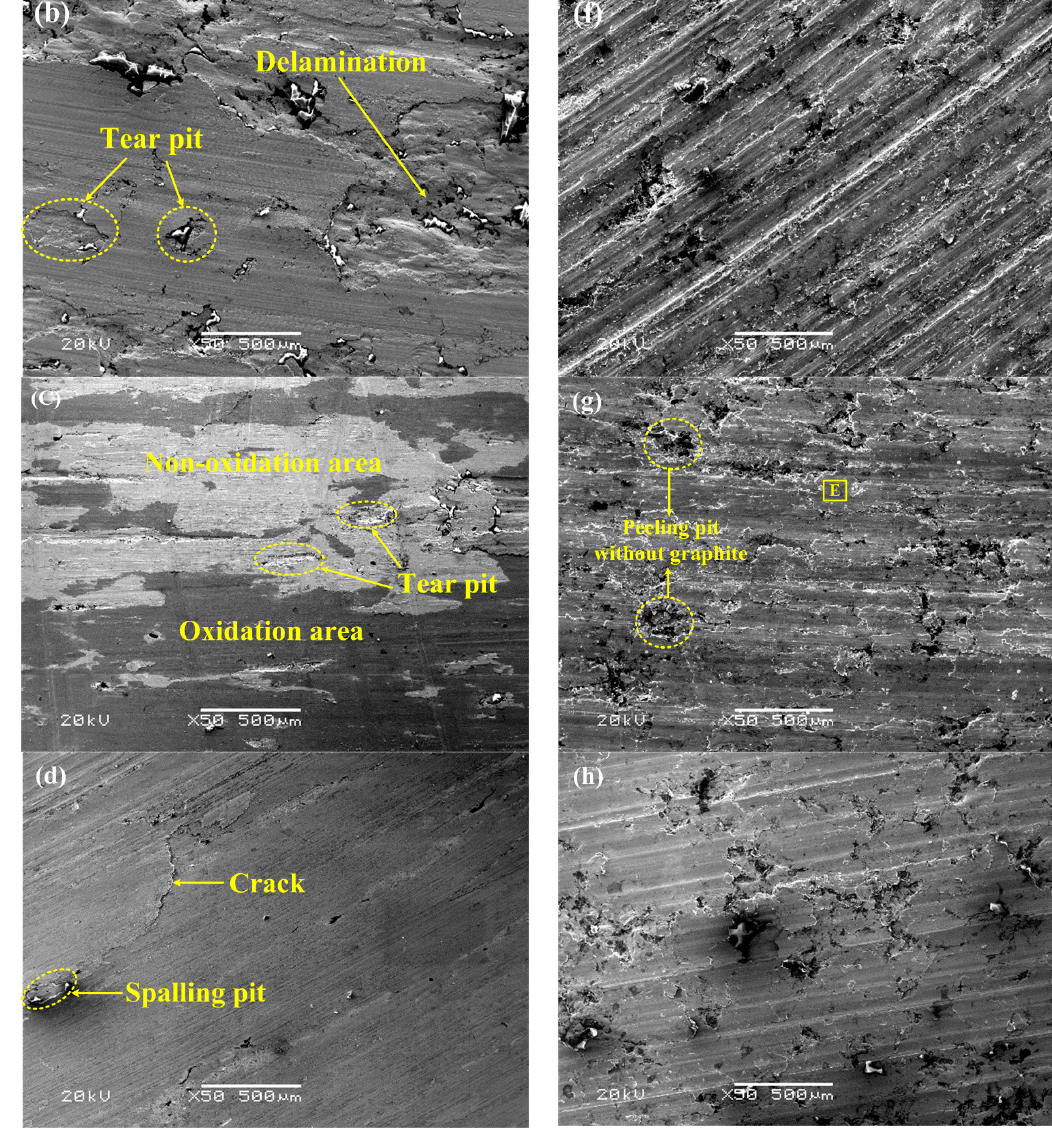
Figure 8. Surface morphologies after tests under different conditions: specimen S1 of ( a ) 100 km/h, 0.4 MPa; ( b ) 100 km/h, 0.8 MPa; ( c ) 250 km/h, 0.4 MPa; ( d ) 250 km/h, 0.8 MPa; specimen S2 of ( e ) 100 km/h, 0.4 MPa; ( f ) 100 km/h, 0.8 MPa; ( g ) 250 km/h, 0.4 MPa; ( h ) 250 km/h, 0.8 MPa. Table 4. EDS analysis results of area A, B, C, D, and E in Figure 8. Content of Elements Area